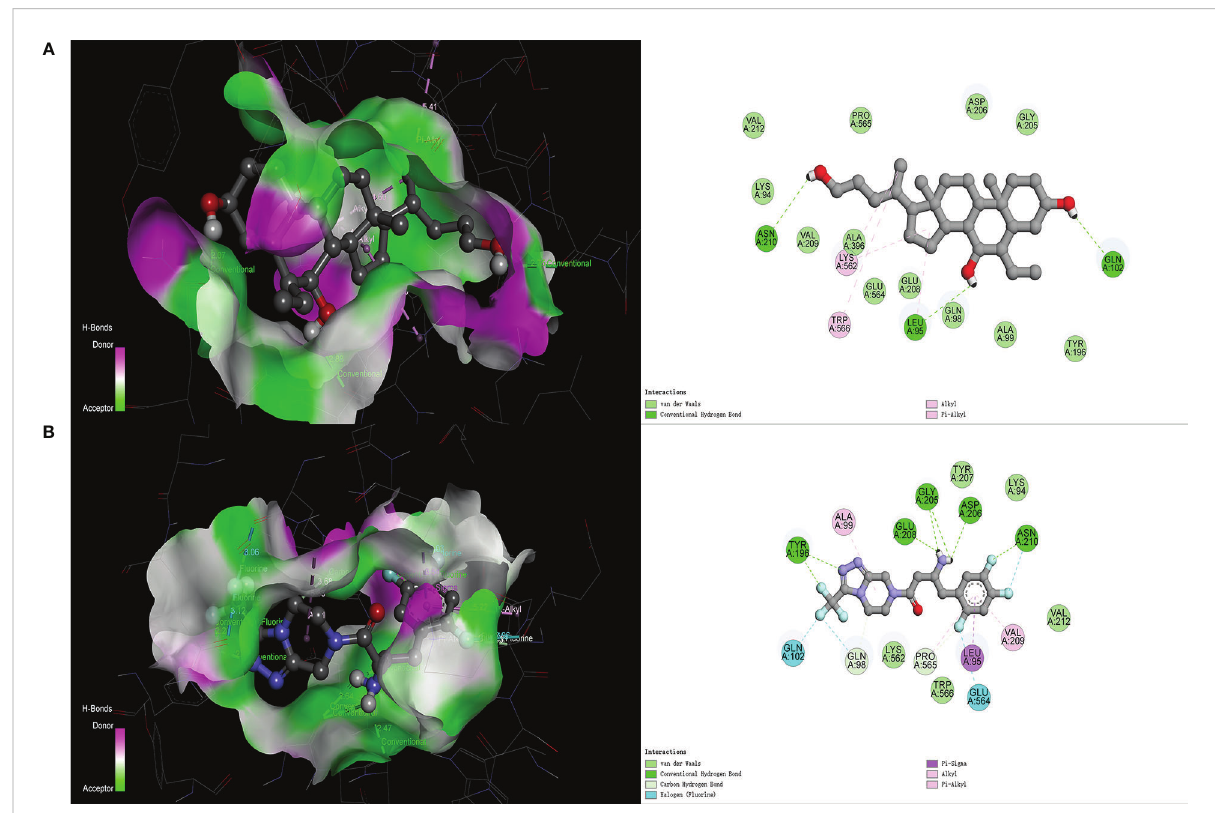
FIGURE 3 Molecular docking of different ligands with ACE2. (A) BAR708 ― ACE2, (B) Sitagliptin ― ACE2. The 3D graphs show the distribution of hydrogen donors and acceptors in the active pocket of ACE2, and the 2D graphs show the amino acid residues and types of bonding in the active